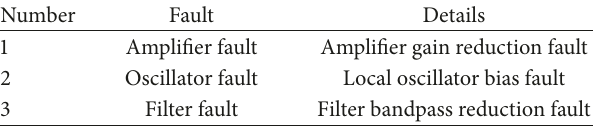
Table 2: Injected fault modes in simulation model.